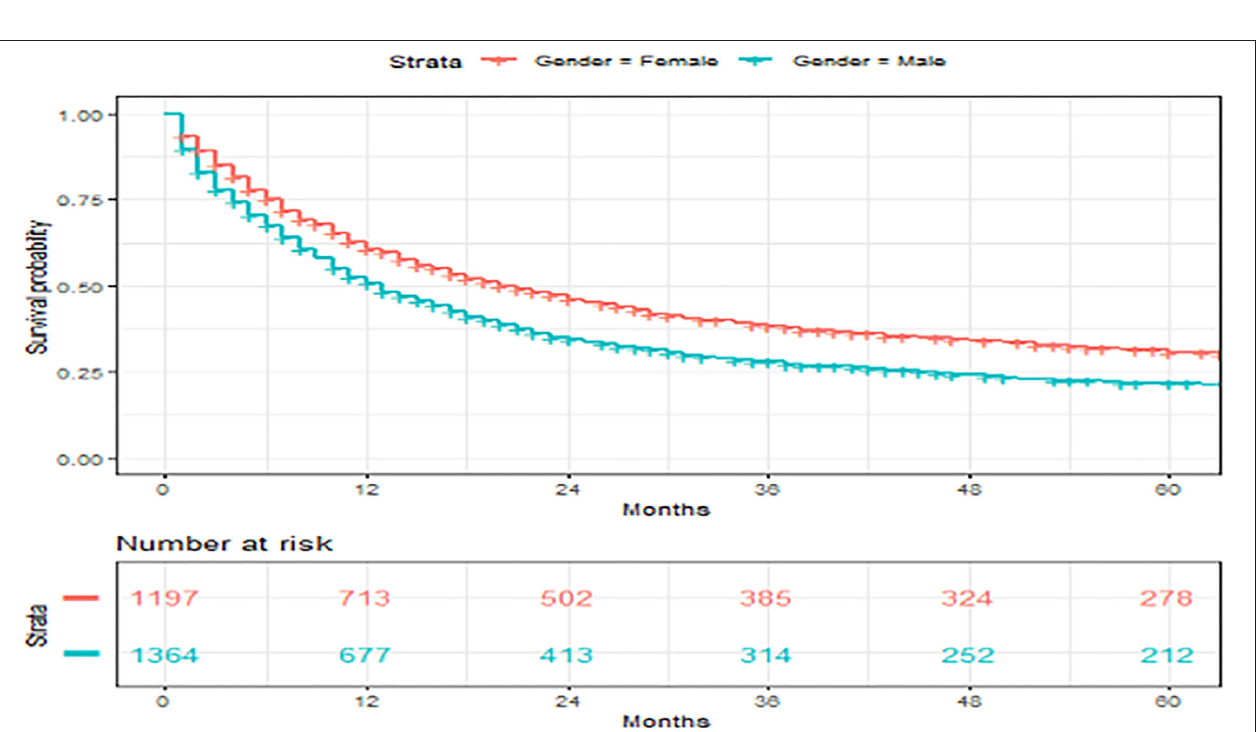
FIGURE 4 | Overall survival of patients with angiosarcoma stratified by gender. Survival was calculated using the Kaplan-Meier methods.